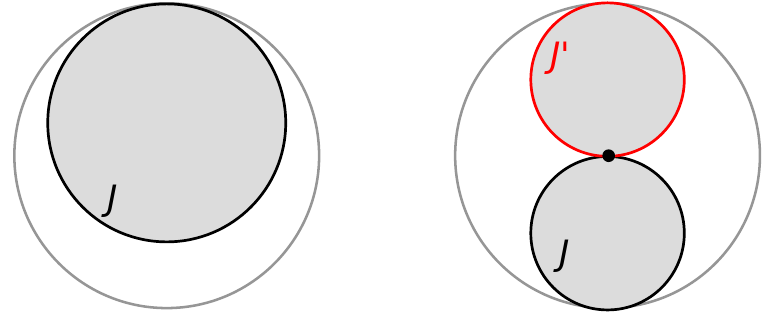
Figure 7 . Left: the ordinary extremal or zero temperature solution. Since the boundary particle intercepts the asymptotic boundary, the total proper time is infinite. Right: if we take β = ∞ while holding the mass of the brane constant, the solution pinches. This means that the correlator between the quench sites is getting large. In the large q theory, we showed that the correlator in fact becomes maximal e g = 1 .